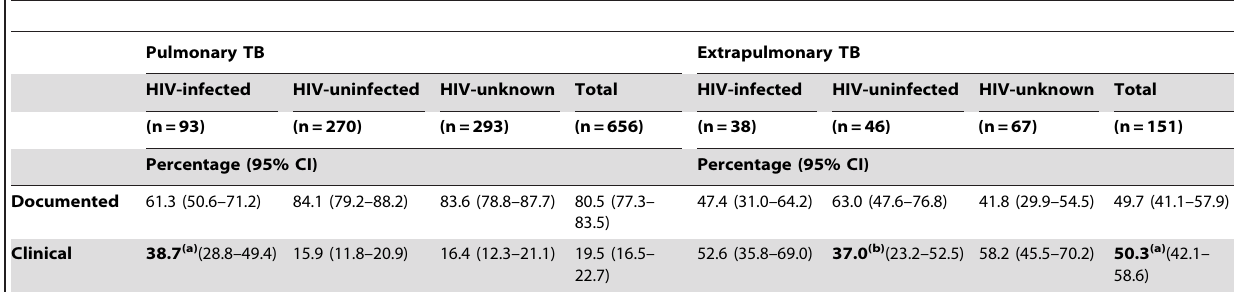
Table 3. Respective proportion of patients classified as microbiologically documented and clinical tuberculosis according to disease localization and HIV-status.